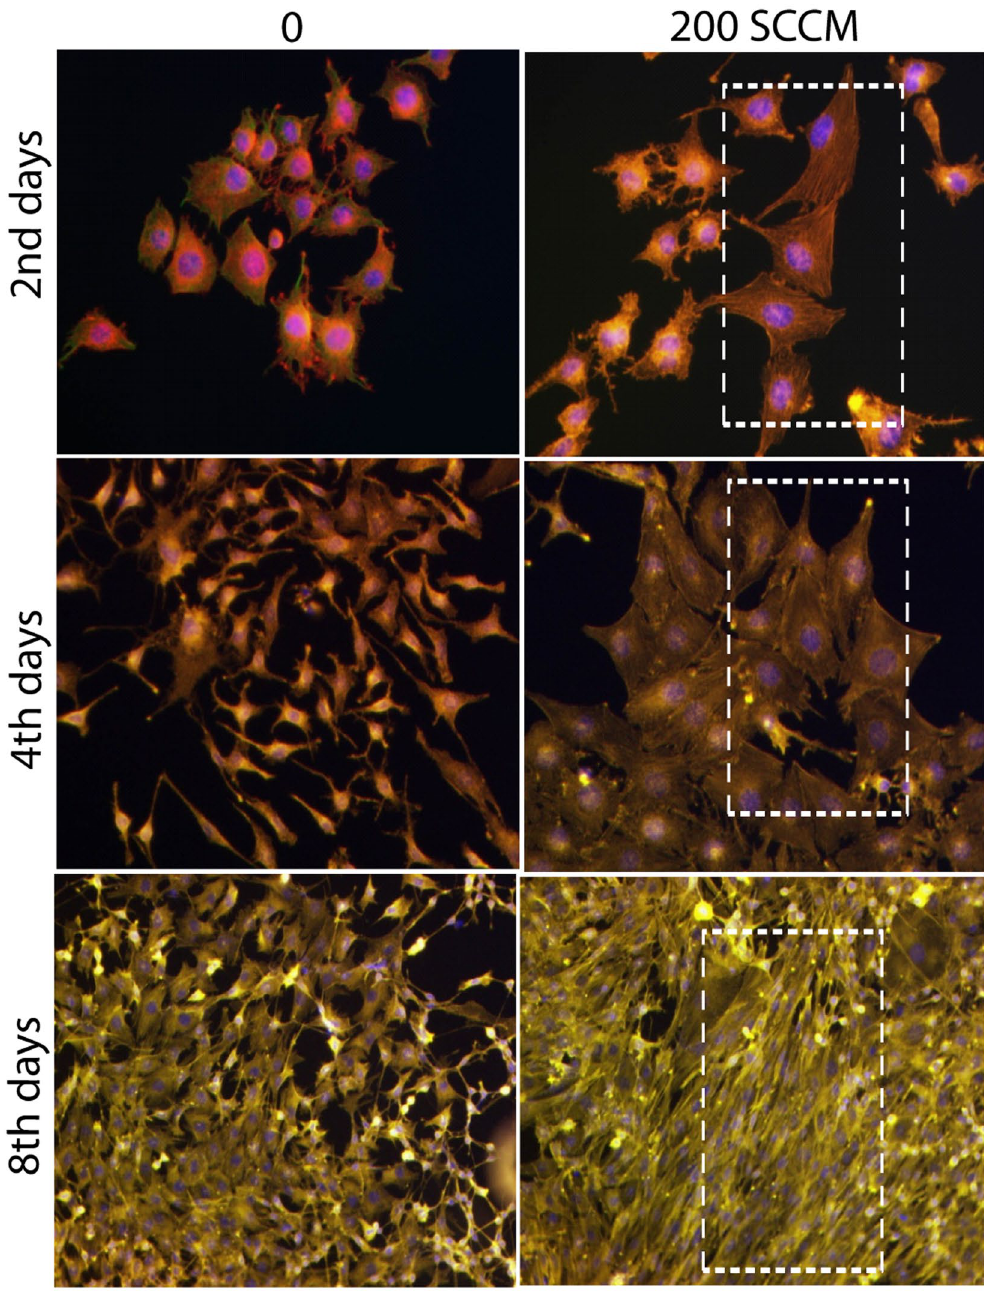
Figure 4. Cellular differentiation analysis through actin, tublin and nuclear immunofluorescence images of L6 cells on day 2, day 4, and day 8 after exposure with NO (200 and 400 SCCM of O 2 flow rate) for 3